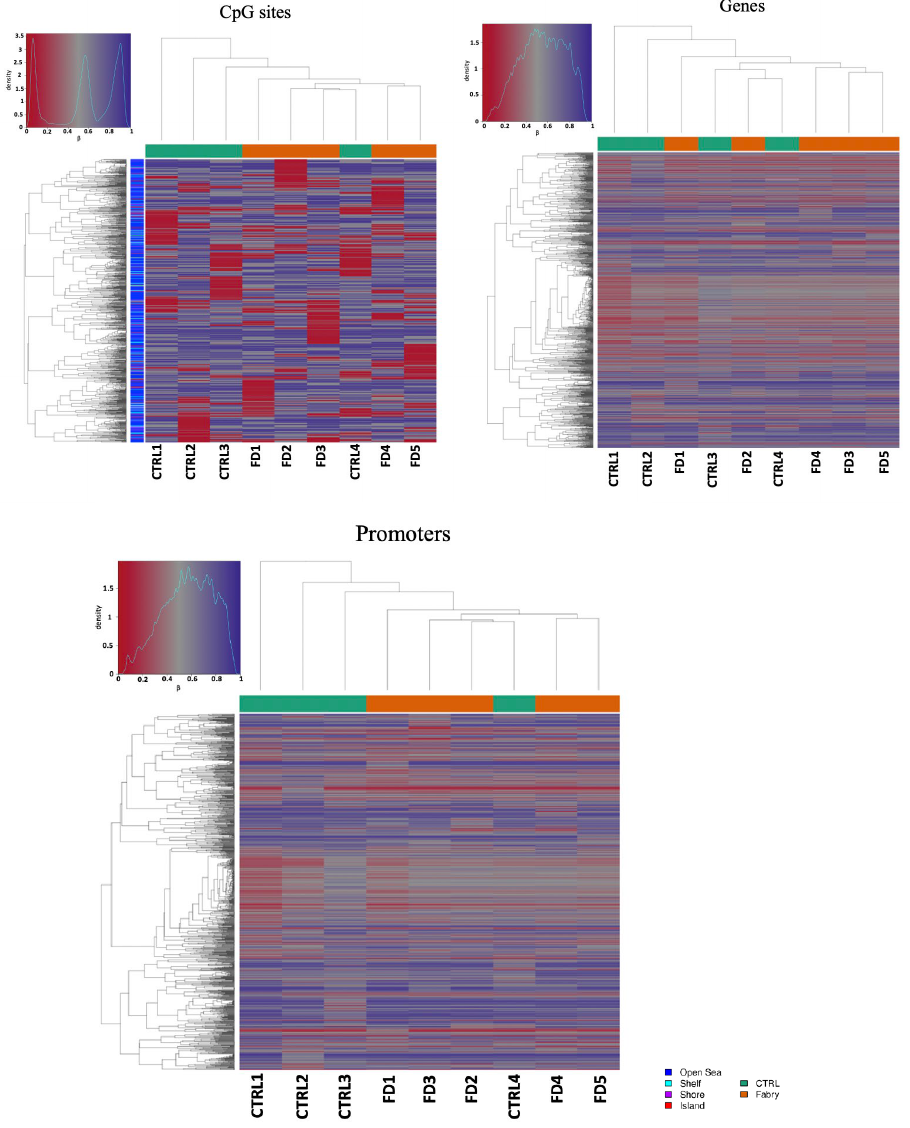
Figure 2. Hierarchical Cluster for the Fabry Disease group and CTRL Group. Heatmaps showing the methylation profiles at selected sites/regions with the highest variance across all